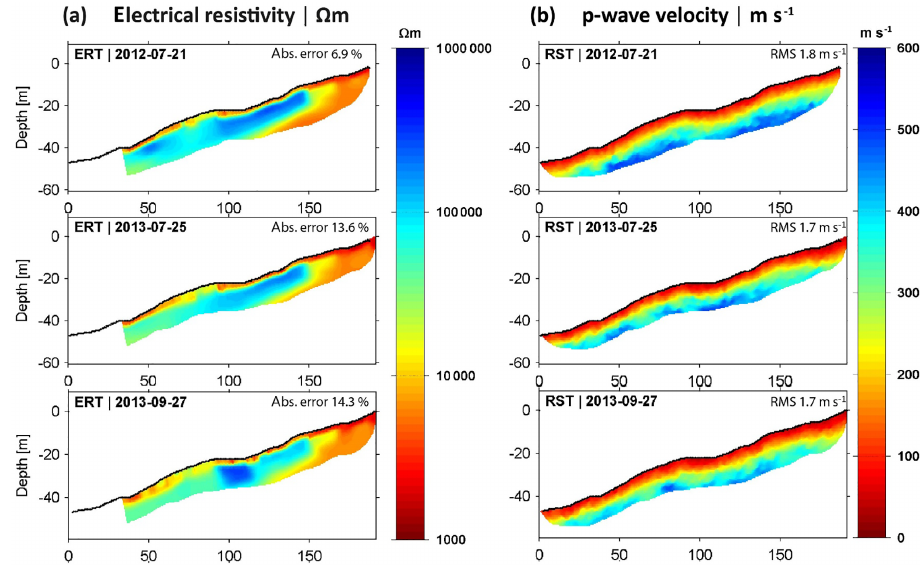
Figure 8. Inverted geophysical monitoring data from the Becs de Bosson rock glacier for three measurement dates in 2012 and 2013.